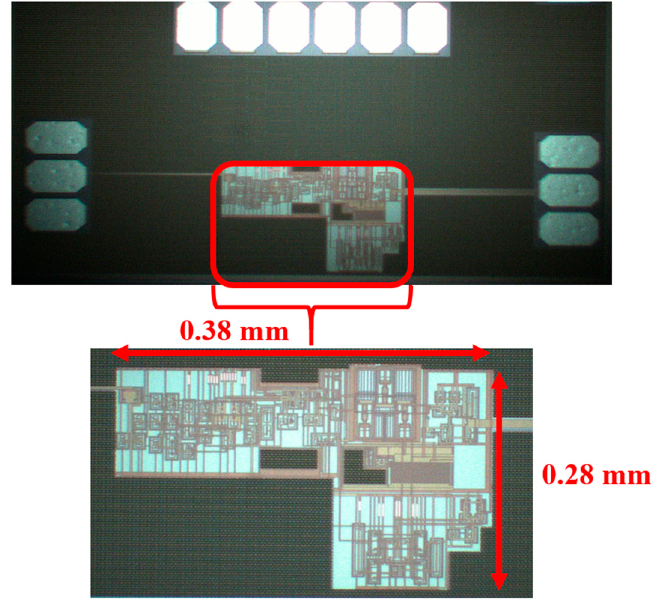
Figure 7. Microphotograph of the circuit.